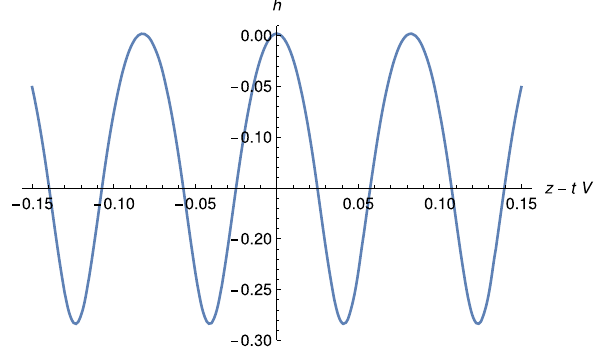
Fig. 4 Plot of the solution (5.23) corresponding to the one real root case. The parameters have the following values: Y = 10 3 , ω 0 = g = 1, λ = V = 0 . 5, χ = 2, κ = 10 3 , z = 0